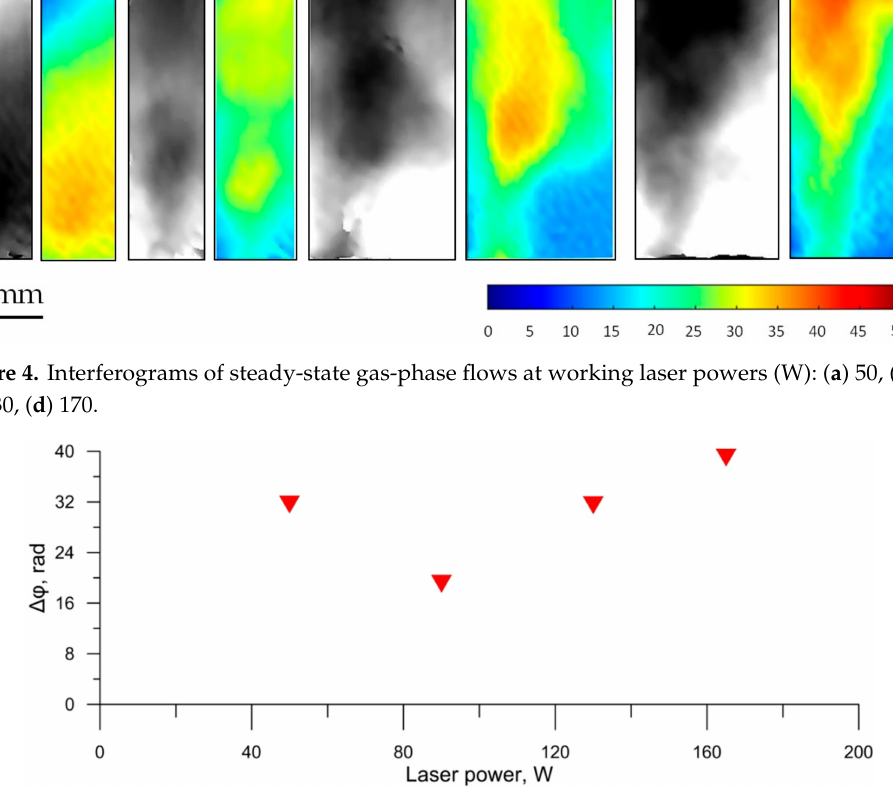
Figure 5. Dependence of the maximum phase increment ∆ φ in the gas-phase flow on power of the working